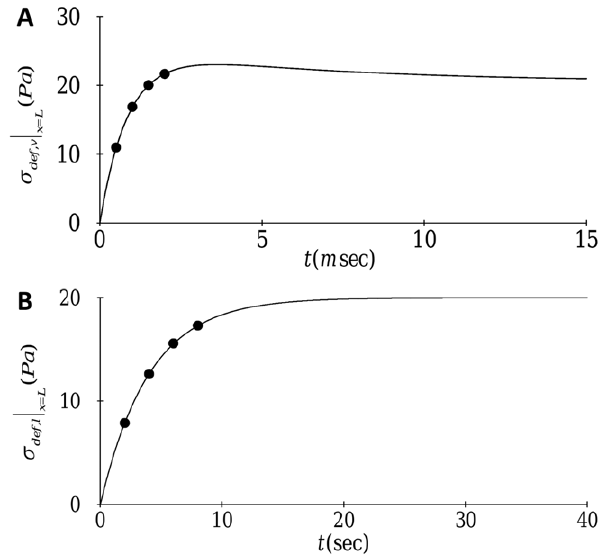
Figure 3. Temporal evolution of the deformation-related stress at the nucleus ( x ~ L ): (A) transverse motion; (B) axial motion. Dots indicate the time corresponding to the displacement snapshots in Fig.